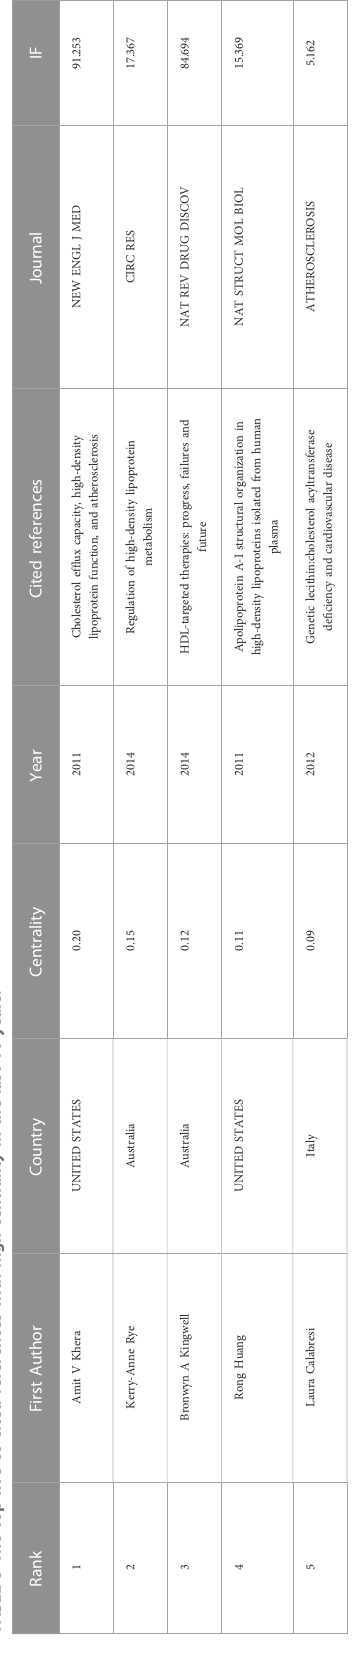
(Table 4). Centrality > 0.1 means that the citation plays a key role in the co-citation network. From the publication with the highest centrality (van Haperen et al., 2000), they indicated that rapid pre- β -HDL conversion to α -HDL normally carrying most of the circulating plasma HDL cholesterol was driven by LCAT. Besides, other studies shown in Table 4 represented a detailed structural and functional analysis of apoA-I in lipid